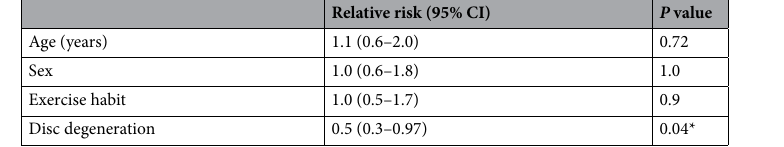
Table 5. Relationship between changes in the luminance of increased CSAs and factors tested by Poisson regression analyses. An asterisk indicates statistical significance. 95% CI, 95% confidence